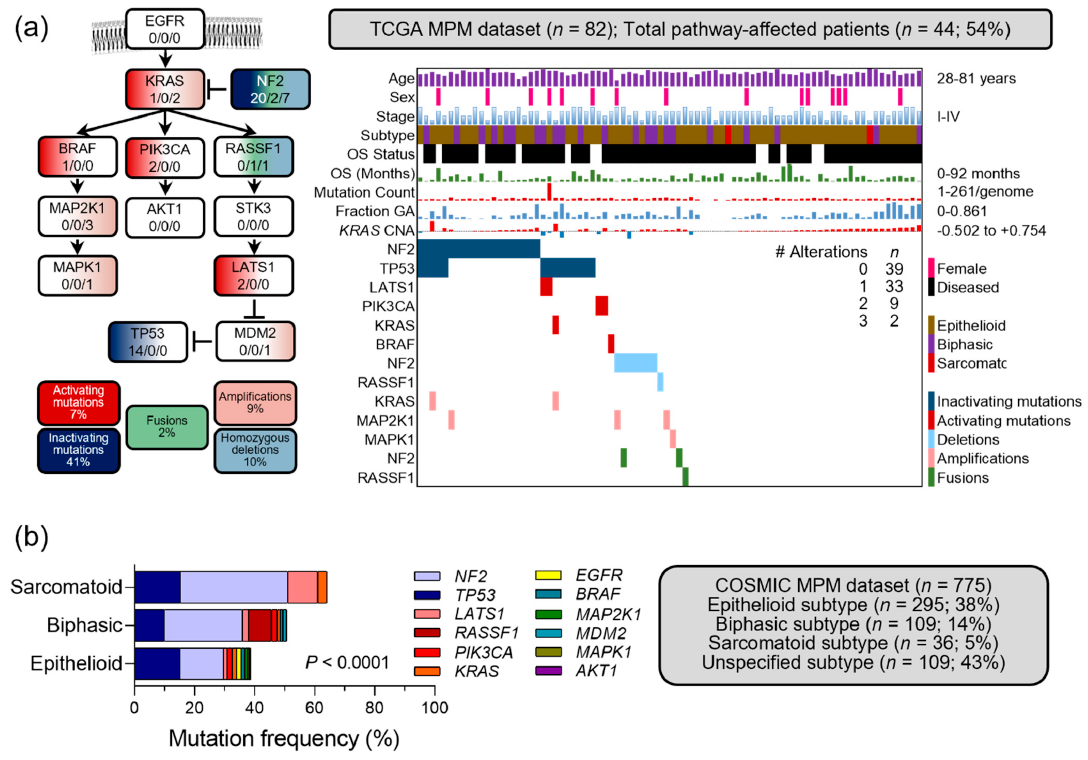
Figure 1. KRAS pathway alterations in The Cancer Genome Atlas (TCGA) and the Catalogue of Somatic Mutations in Cancer (COSMIC) MPM datasets. ( a ) A biological KRAS pathway as proposed by Matallanas et al. in 2011 [22]. Shown are its 13 genes (boxes) interconnected via activating (arrows) and inhibitory (dead-end) signaling events, together with color-coded alteration types and frequencies (legend). Numbers in boxes denote the numbers of TCGA MPM patients ( n = 82 with full data) with mutations/fusions/copy number alterations for each gene. ( b ) Clinical and molecular data summary of TCGA MPM patients with KRAS pathway genes, color-coded clinical and molecular data plot (heatmap), number of patients with no, one, two, or three pathway alterations (table insert), and legend. OS, overall survival; GA, genome altered; CNA, copy number alteration. Raw data shown as patient numbers ( n ) and percentages (%) from Hmeljak et al., 2018[4], were retrieved from https://www.cbioportal.org/ (accessed on 3 March 2022) using permanent link https://bit.ly/3BypsnC (accessed on 3 March 2022), and were manually analyzed and visualized on Microsoft Excel and PowerPoint. KRAS pathway mutation frequencies in MPM from COSMIC, stratified by histologic subtype (available at https://cancer.sanger.ac.uk/cosmic/browse/tissue?wgs=off&sn= pleura&ss=all&hn=mesothelioma&sh=&in=t&src=tissue&all_data=n (accessed on 3 March 2022); n = 775 patients). Shown are data summary and table, presented as mutation numbers ( n ) and frequencies (%). Note the gradually increasing cumulative mutation frequency of the pathway in biphasic and sarcomatoid MPM compared with epithelioid MPM. p , probability, 2-way